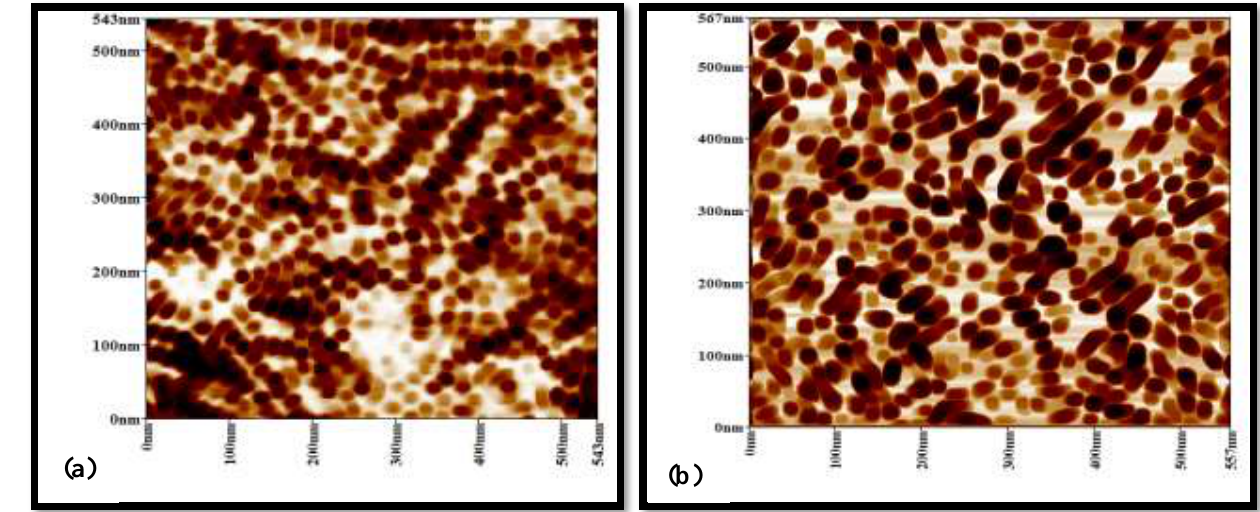
Figure 4: 2-D AFM images related to the samples of PSi at various etching current densities (a) 12 and (b) 30 mA/cm 2 , HFc 40%, and etching time 10